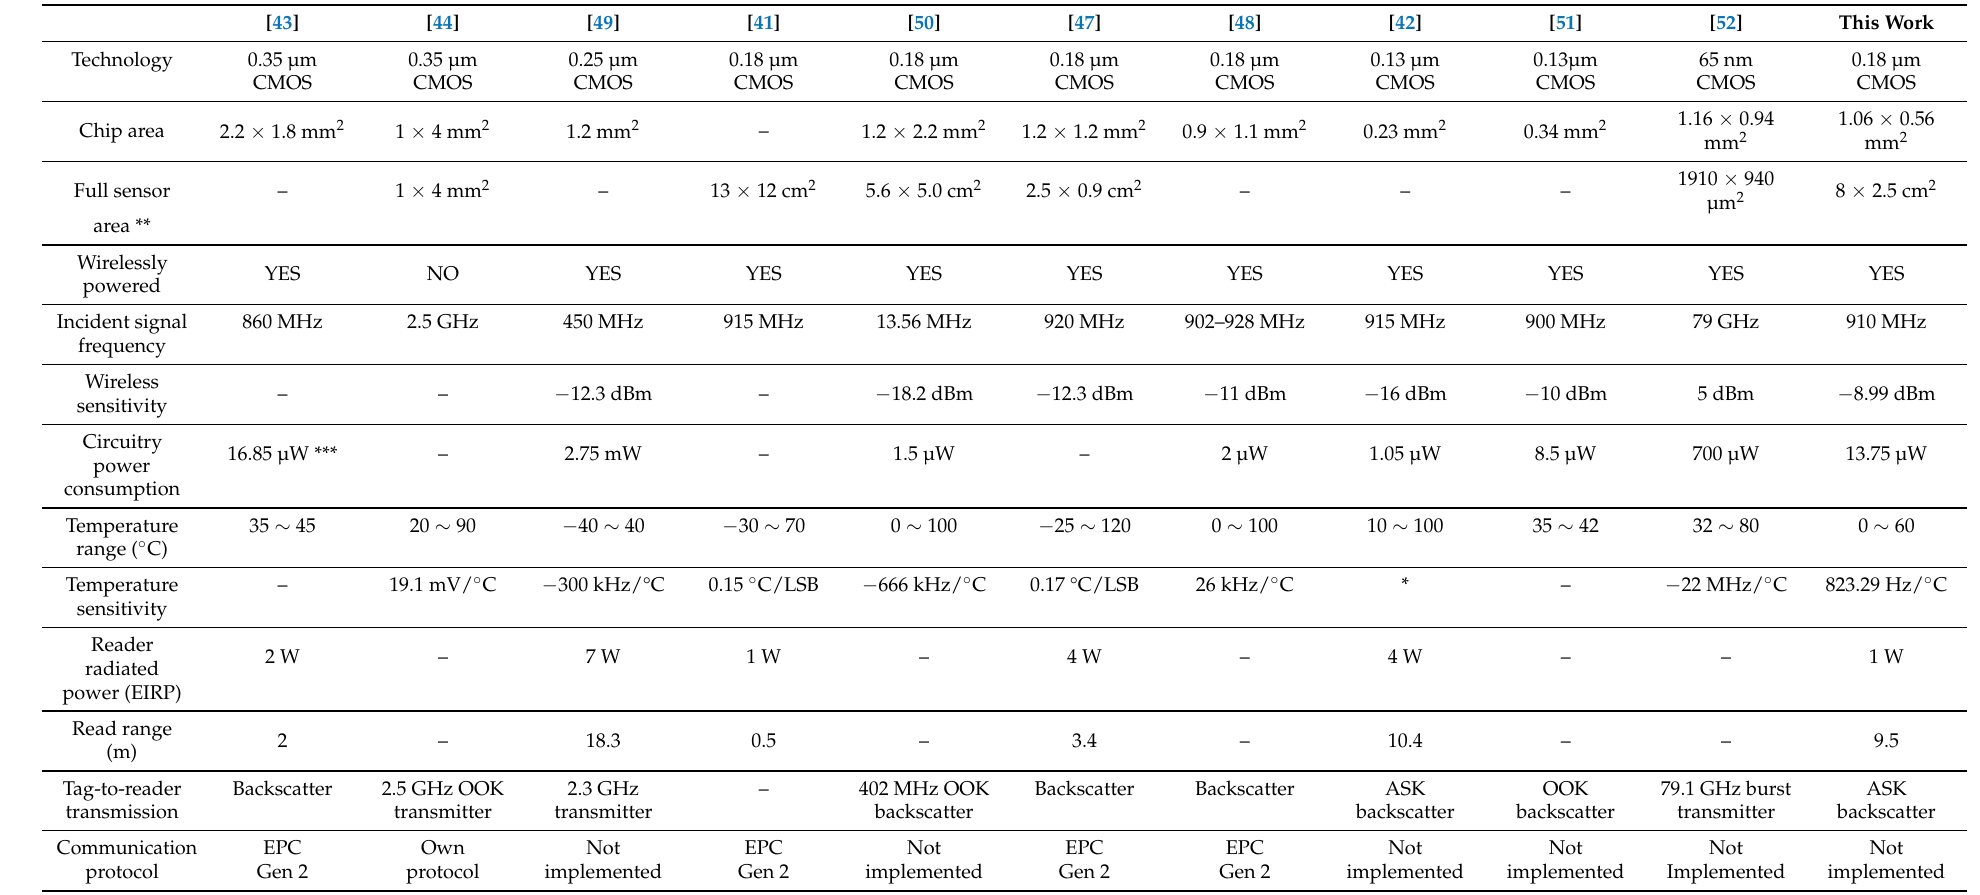
Table 9. Comparison with previous